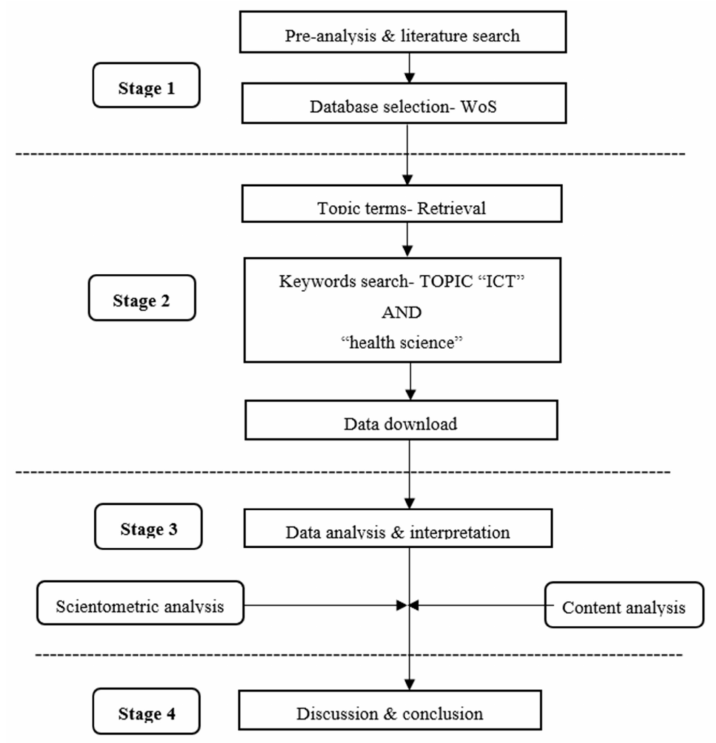
Figure 1. Research flowchart